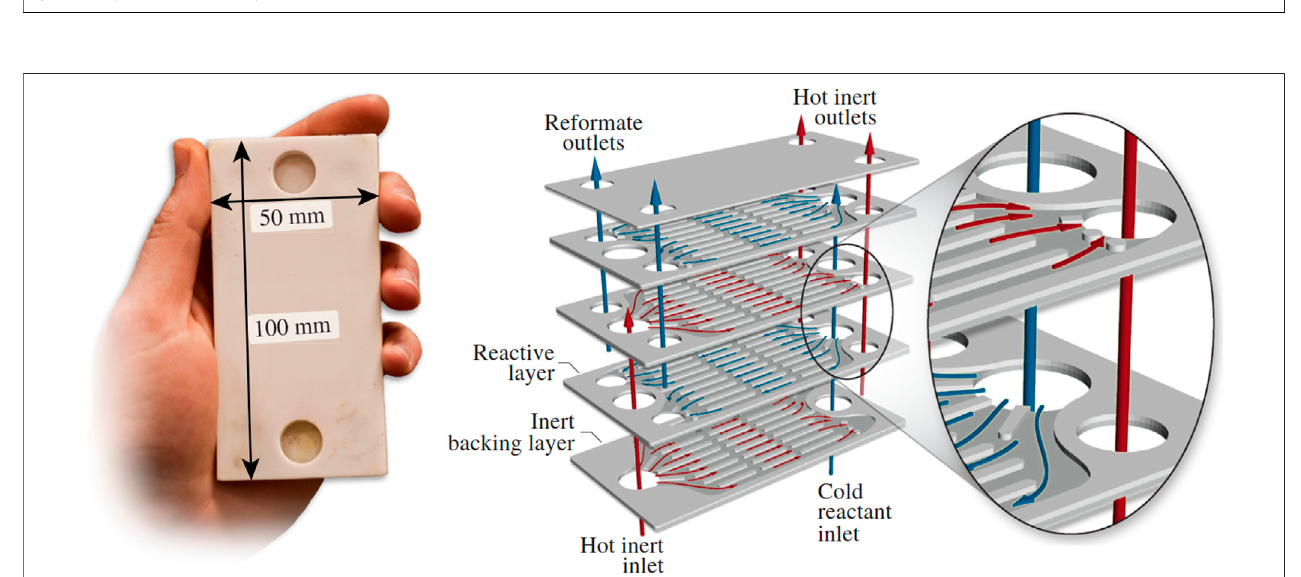
FIGURE 5 | Schematic representation of the layout and size of microchannel reactors (Murphy et al., 2013).